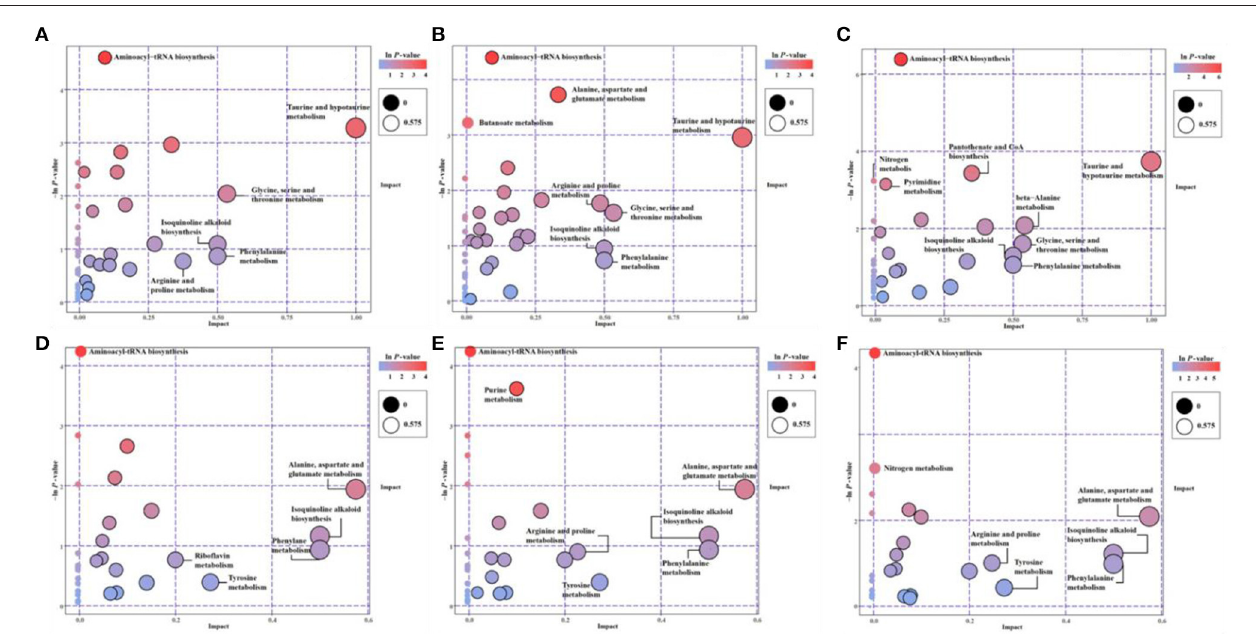
FIGURE 3 | The pathway enrichment and topology analysis of candidate metabolites from E. gracilis under different environmental stresses. (A–C) NEG modes; (D–F) POS modes. (A,D) PRM-NEG, PRM-POS; (B,E) Cd-NEG, Cd-POS; (C,F) N-NEG, N-POS. “Pathway Impact” on the x -axis represents the impact of these enriched pathways computed via topology analysis. “–log10( p )” on the y -axis refers to the negative natural logarithmic value of the original p -value from a statistical analysis of the pathway difference between the groups of stresses vs. the EM control. The redder the color, the higher the –log10( p ) and pathway impact value, the more significant the enrichment